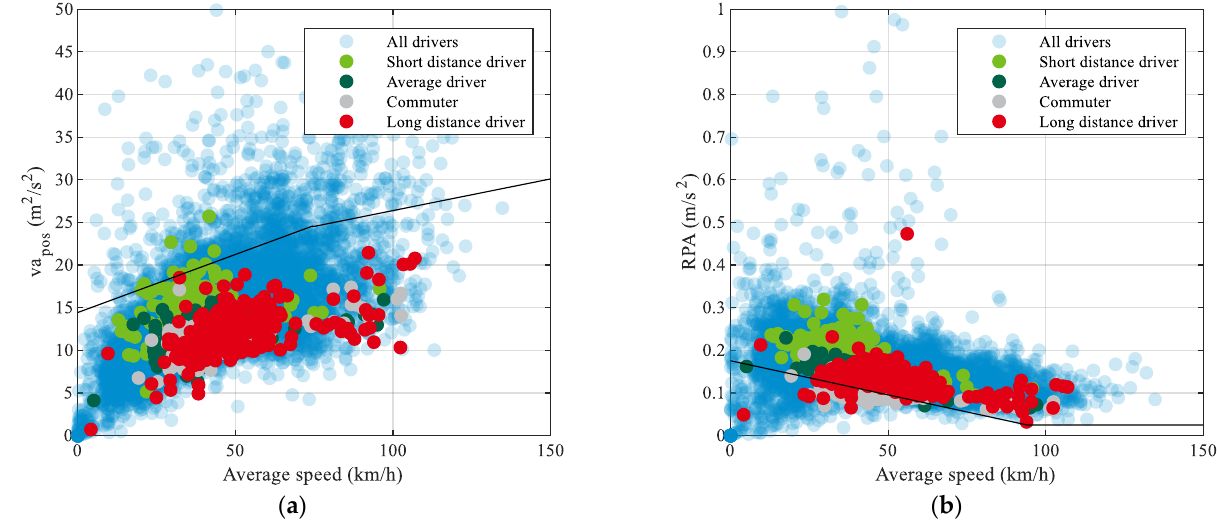
Figure 2. Comparison of ( a ) va pos and ( b ) RPA of the selected drivers to the fleet data.